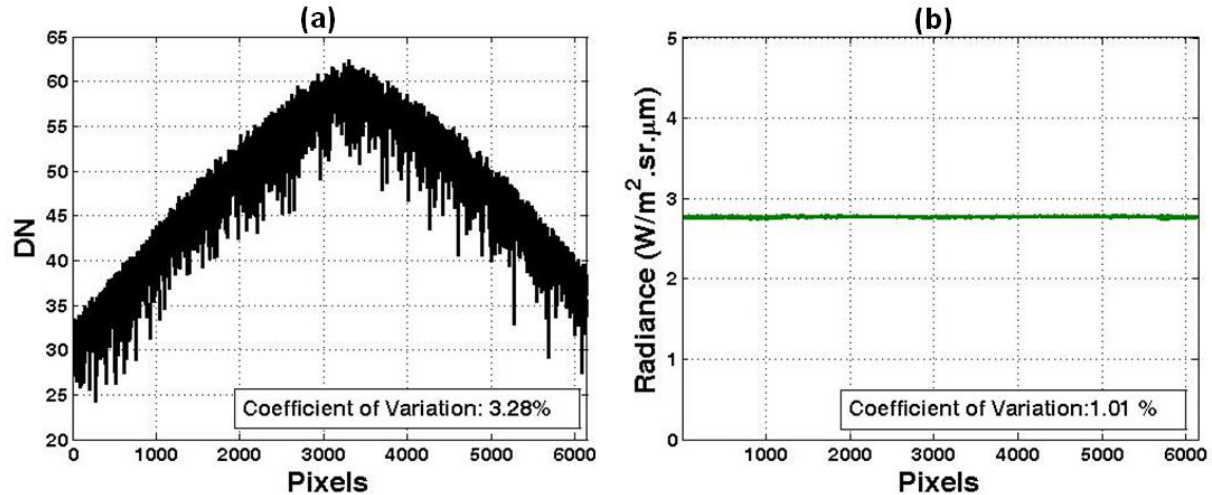
Figure 6. Results of 200  s NIR. (a) Uncorrected data; (b) Radiance of calibrated data. The coefficient of variation for (a) was estimated after the vignette effect was corrected.